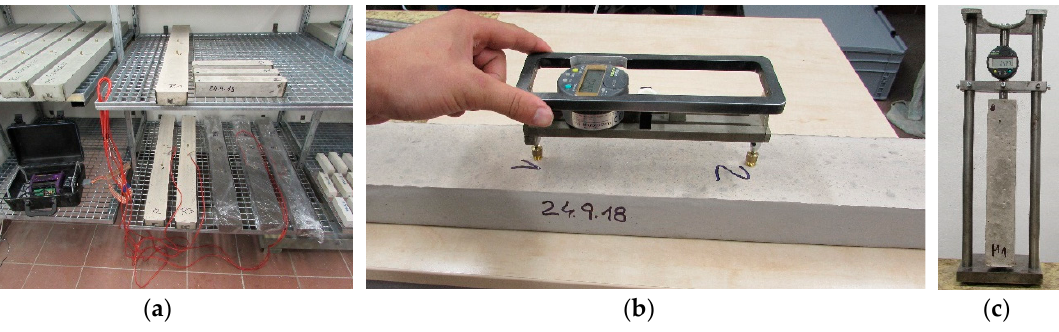
Figure 4. Illustrative photo of long-term measurement: Overall view ( a ); M-SG (Hollan) for specimens 100 mm × 60 mm × 1000 mm ( b ); dilatometer for specimens 50 mm × 50 mm × 300 mm ( c ).